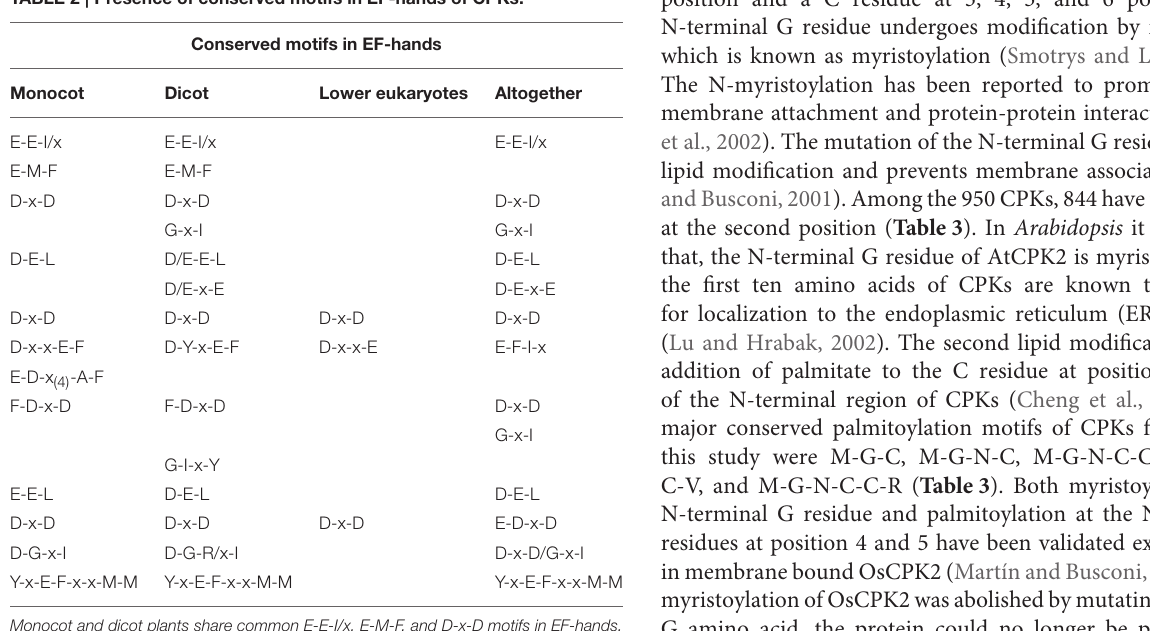
TABLE 2 | Presence of conserved motifs in EF-hands of